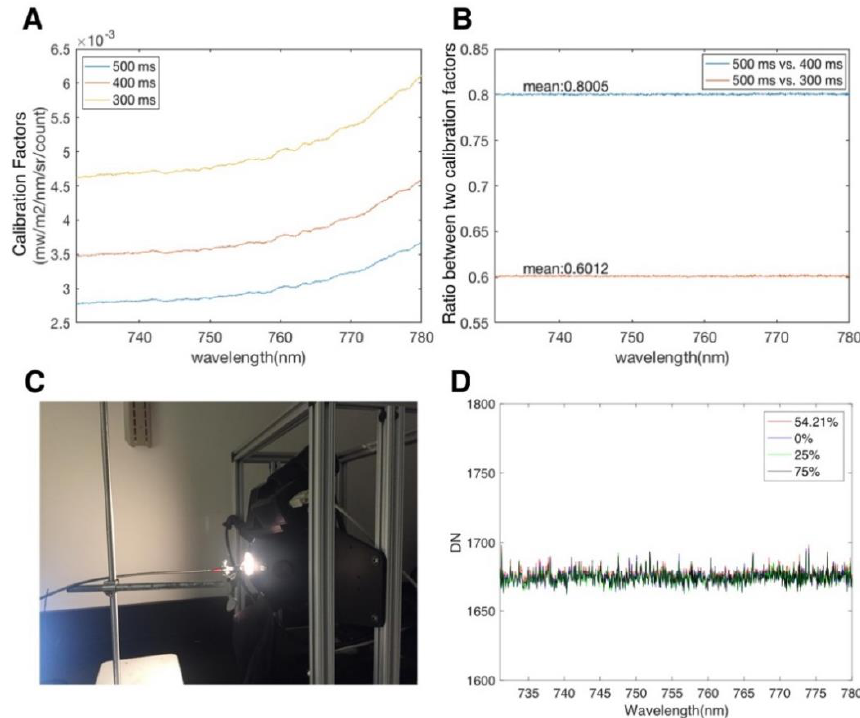
Figure 2. Lab tests of FluoSpec 2. ( A ) Calibration Factors estimated using FluoSpec 2 and the HELIOS integrating sphere. The calibration factors were collected under various integration times. ( B ) The ratio between calibration factors at 500 ms, 400 ms, and 300 ms. ( C ) Lab set-up when calibrating FluoSpec 2 and testing whether the shutter is “light-tight”. ( D ) Digital numbers (DNs) measured at various light intensities. The attenuator is fully open at 0%, and the light intensity in this setting is twice the intensity of peak solar radiation.